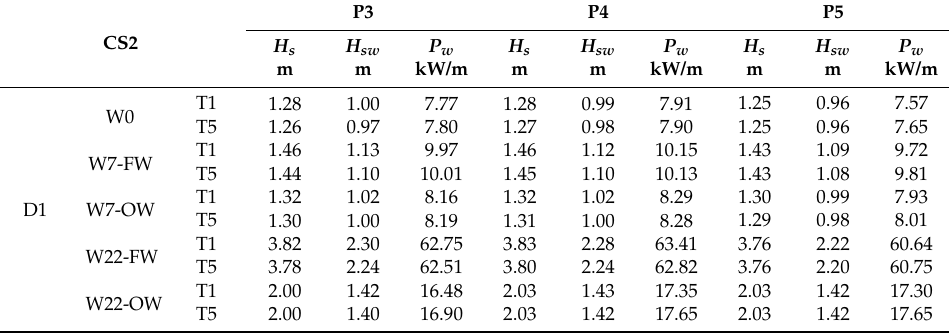
Table 5. SWAN results for CS2, corresponding to the reference points P3, P4, and P5, the tide levels T1 and T5, and the wind conditions W0, W7, and W22, in terms of the wave parameters H s , H sw , and P w